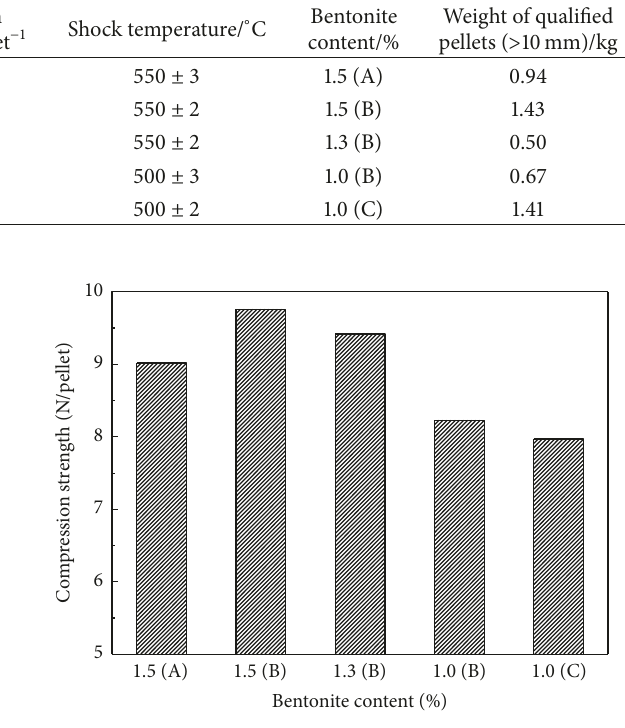
Figure 6: Effect of different types and proportions of bentonite on the compression strength of the